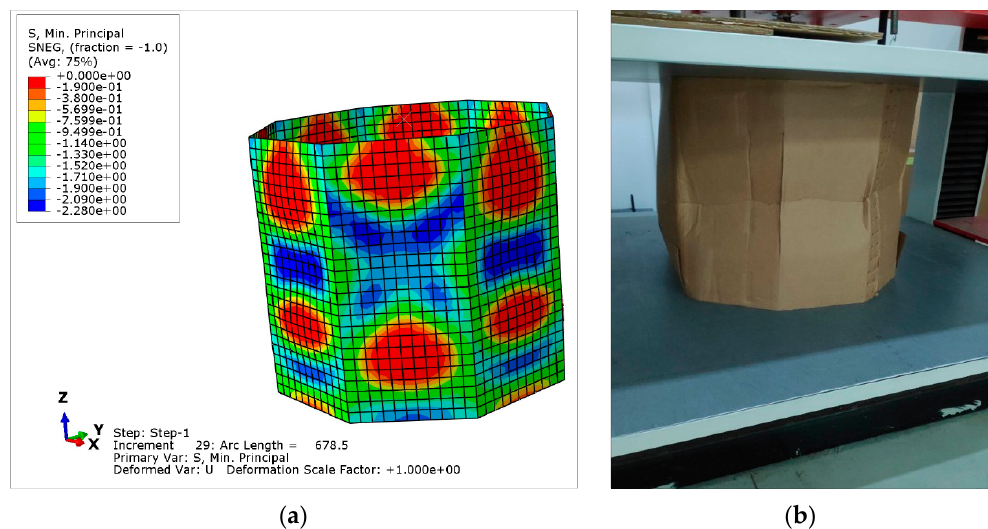
Figure 11. Qualitative comparison between CAE and experimentation for O-04 item: ( a ) CAE deformed model and stress field (stress legend in MPa); ( b ) Deformed sample in the BCT test.